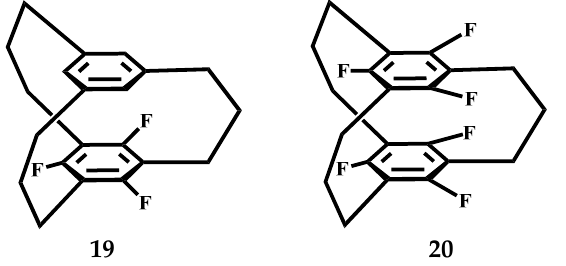
Figure 12. The conformation of Trifluoro- and hexafluoro [3 3 ](1,3,5)CP 19 and 20 .